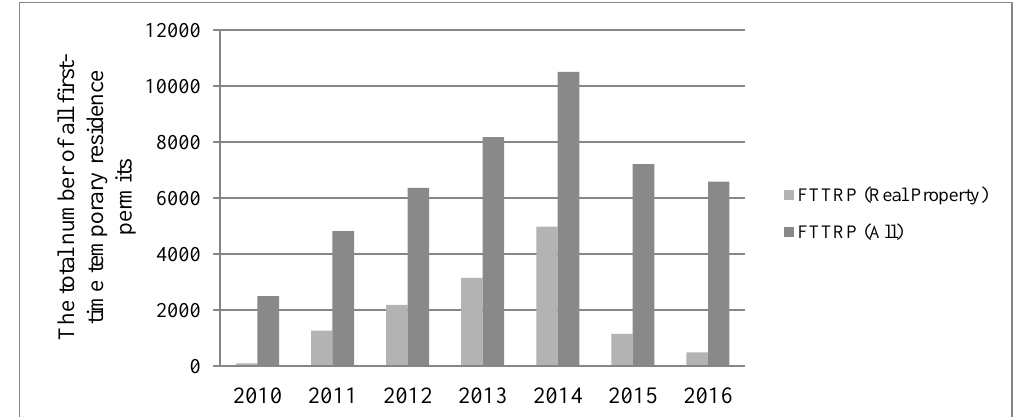
Fig. 3. The total number of all first-time temporary residence permits (FTTRP) and the number of FTTRP based on real property investment (FTTRP (Real Property)) issued in Latvia from 2010 to 2016. (developed by the authors based on the data of the Office of Citizenship and Migration Affairs of